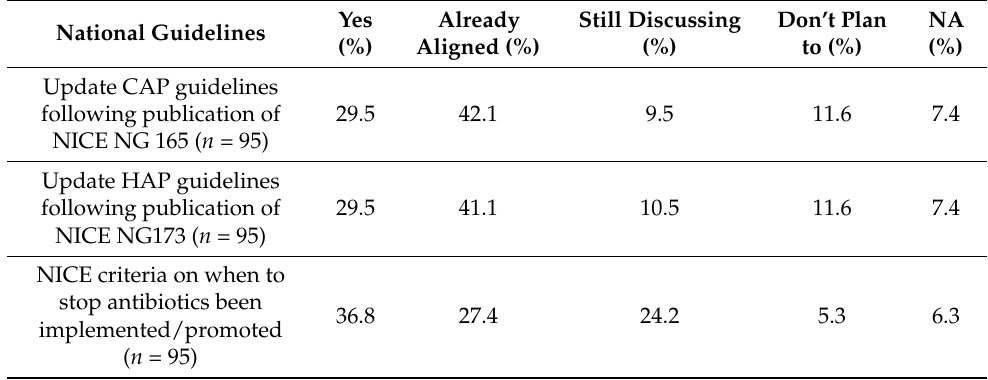
Table 2. Organizations updating guidance in line with NICE recommendations (n = 95